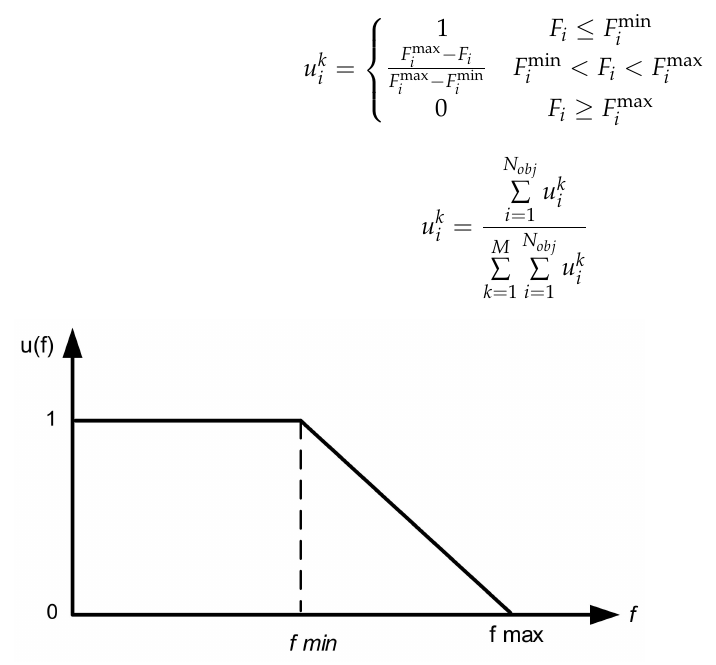
Figure 2. Membership function. The maximum value of u k represents the best compromise solution